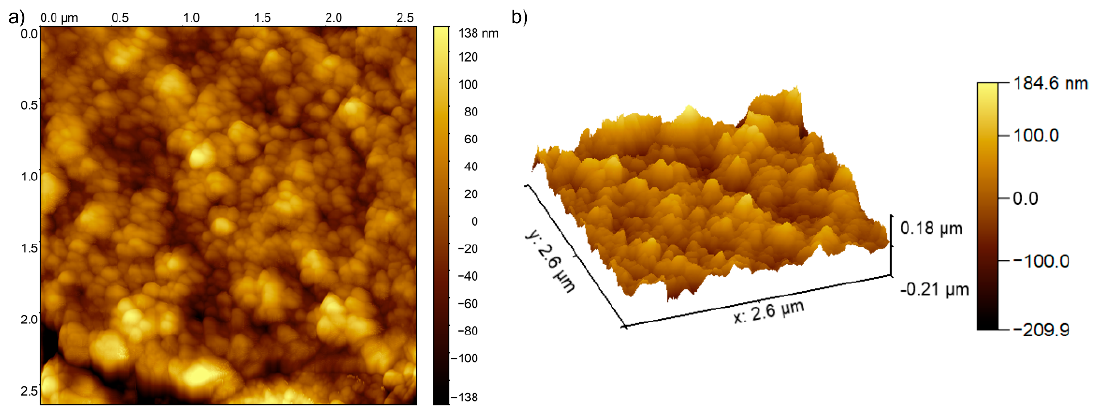
Figure 5. Representation of the atomic force microscopy (AFM) topography image of the AgZnHApCs coating’s surface ( a ) and 3D representation of the surface topography of AgZnHApCs coatings ( b ).